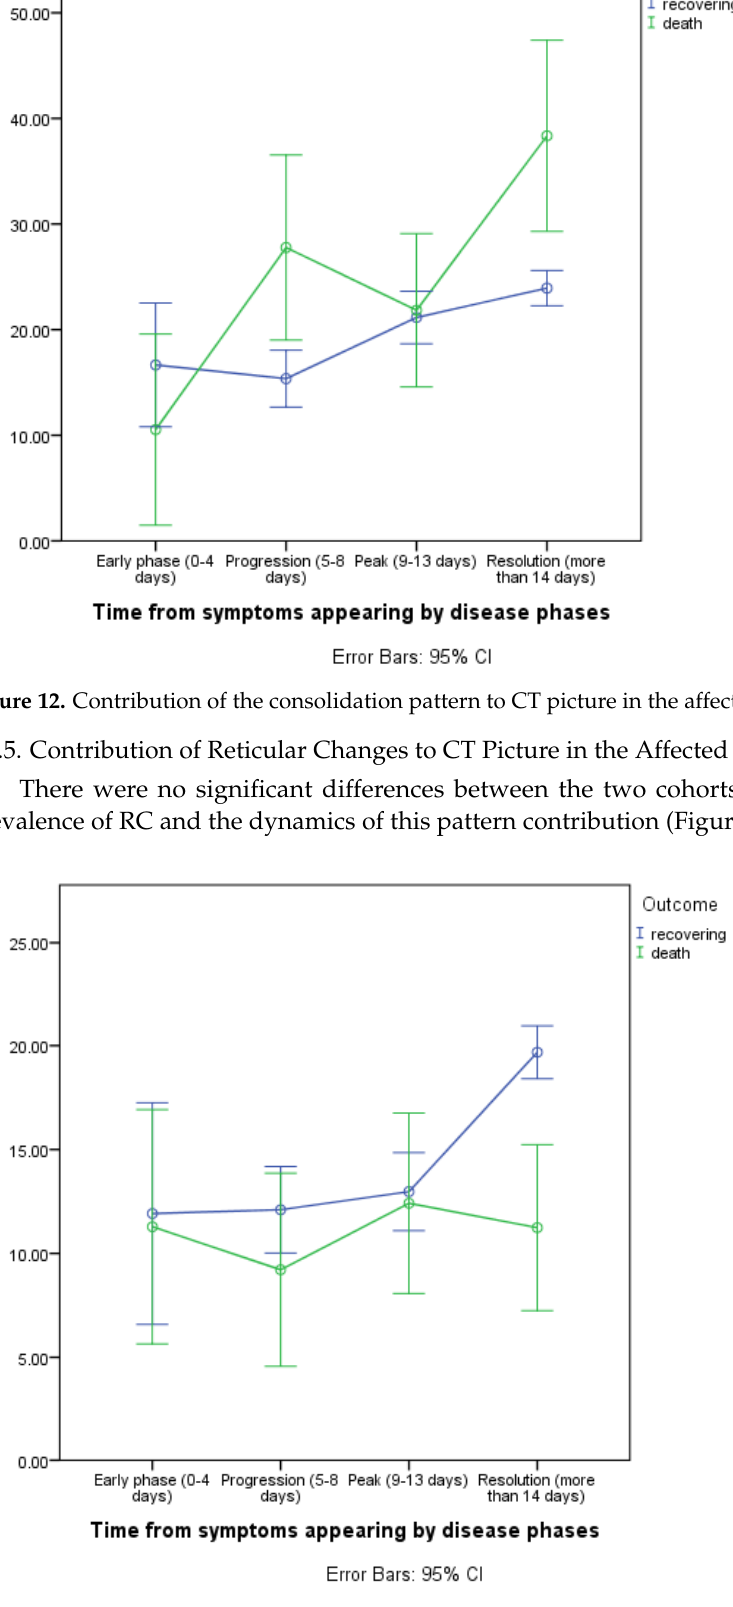
Figure 13. Contribution of reticular changes to CT picture in the affected areas.